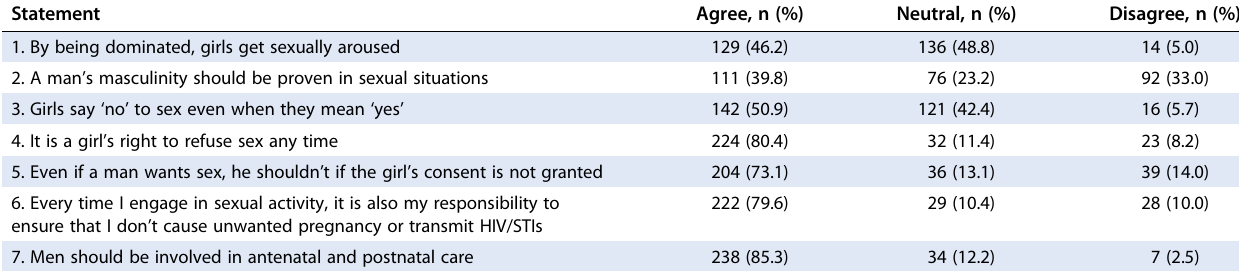
Table 3: Participants ’ attitudes towards women and sex Statement